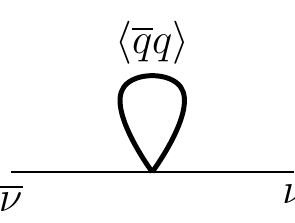
Figure 2 . Contribution to neutrino masses from quark condensates induced by scalar interactions. The contribution can be of Dirac or Majorana type depending on whether the scalar coupling is or not lepton number violating. The loop refers to quark condensates. It is just a diagrammatic representation and so no loop suppression factor is